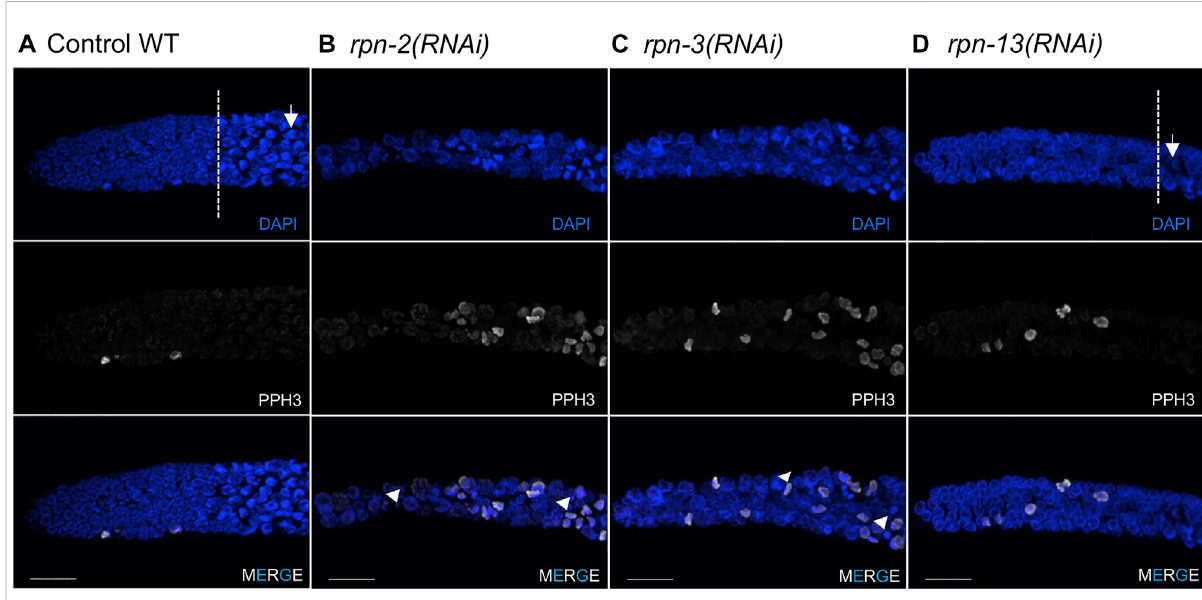
FIGURE 3 Defects in the mitotic germ line result from 19S RP subunit knockdown. Representative images of the distal tip of the C. elegans germ line visualized with DAPI (blue) and phospho-H3 Ser10 (white). (A) Wild type N2 controls [white dash line indicates start of transition zone with characteristiccrescentshapenuclei(whitearrow)]. (B,C) Wormstreatedwith rpn-2(RNAi) or rpn-3(RNAi) presentedanincreasednumberofcellsinM phase and the presence of small or fragmented nuclei (white arrowheads). Both also had shorter mitotic tips with no clear transition zone. (D)